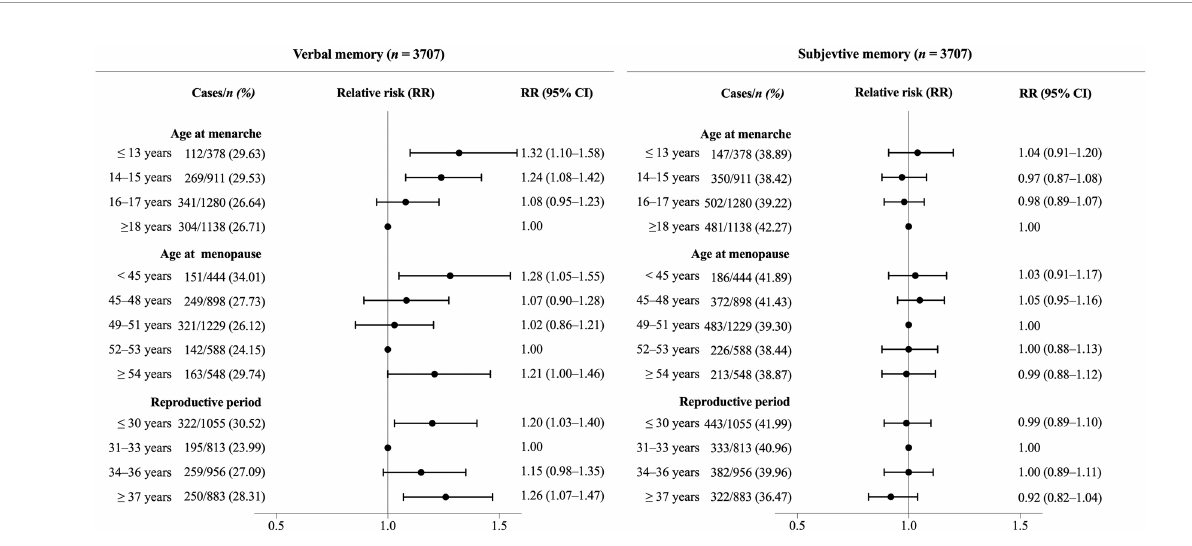
FIGURE 2 | Association between reproductive period, age at menopause, age at menarche, and risk of memory impairment in postmenopausal women. Poisson regression models with a robust error variance were used to estimate relative risks (RRs) and 95% con fi dence intervals (CIs). All RRs were adjusted for age at memory evaluating, education, marital status, area of residence, smoking status, drinking status in the past year, physical activity, BMI, and history of hypertension, diabetes, and stroke. Age at menarche and age at menopause were mutually adjusted in the analyses.